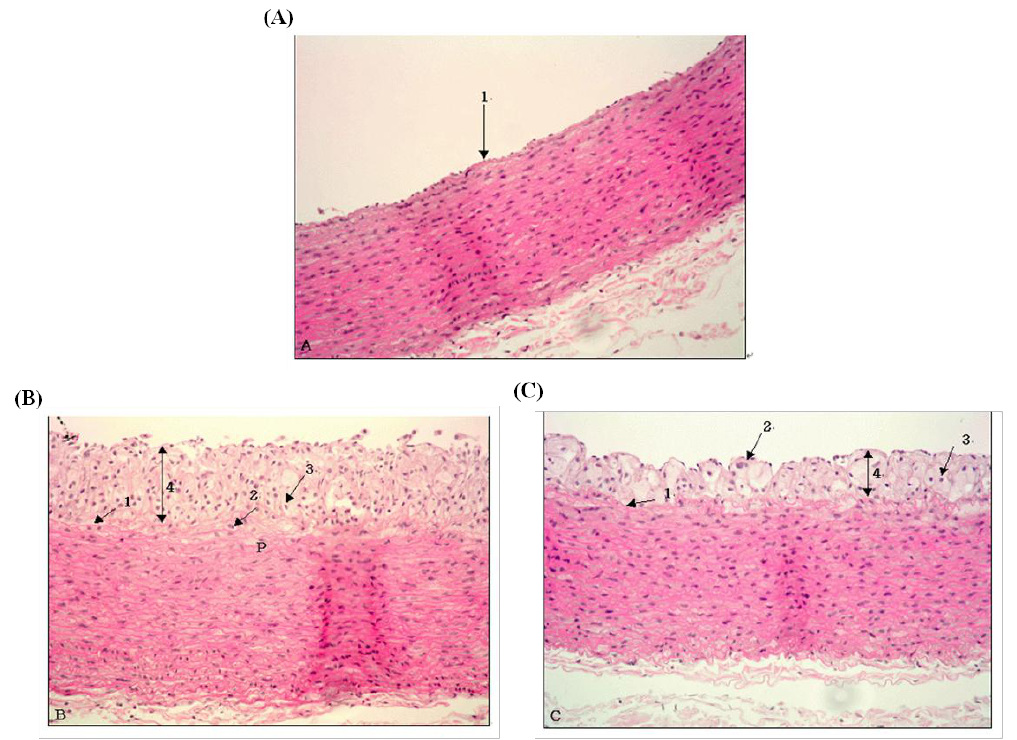
Figure 2. The aortic cross-section in the rabbits fed the experimental diets. ( A ): normal diet ( B ): high cholesterol diet ( C ): high-cholesterol diet containing 0.05% white ginseng low-molecule extracts (Magnification = 200×). * Note the thickening of intima and media due to edema and atheromatous plaque in the thoracic aorta in (B). 1: internal elastic lamina; 2: macrophage; 3: foam cell; 4: atheromatous plaque. ** Thickening of intima resulting from formation of atheromatous plaque was considerably attenuated ( C ).